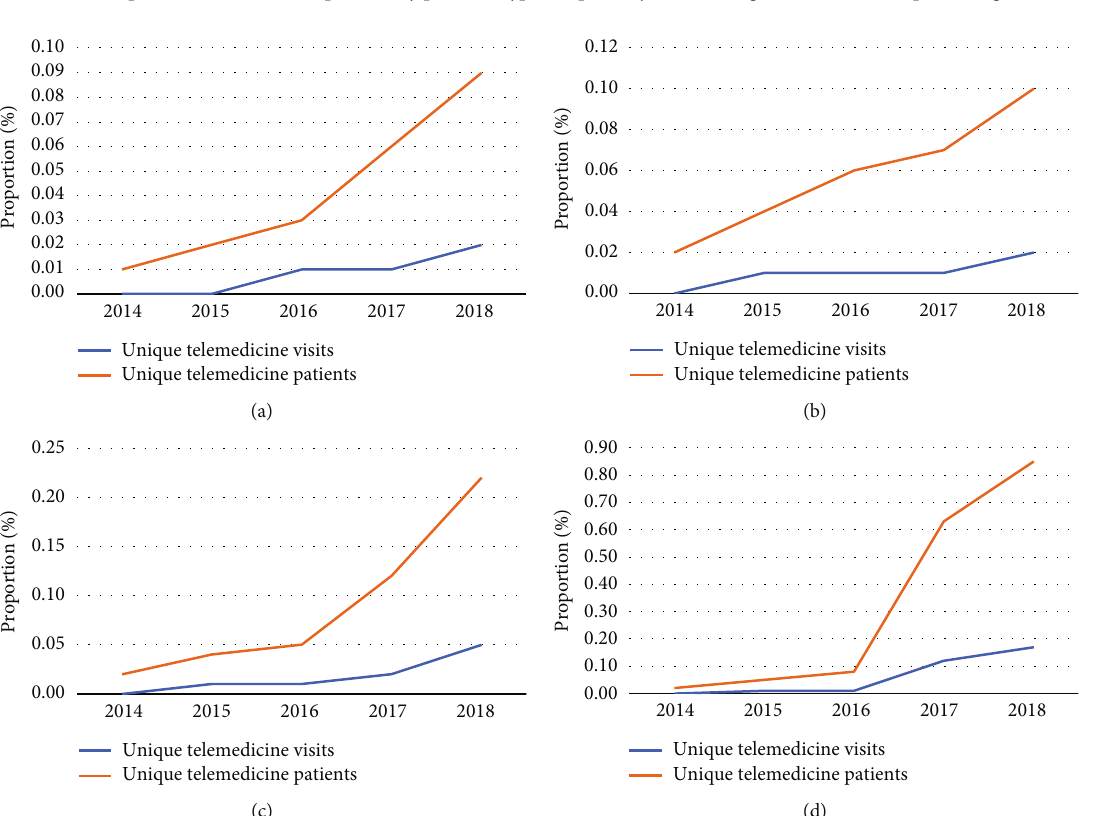
Figure 3: Trends in unique telemedicine visits/patients by provider type: (a) primary care, (b) urgent care, (c) orthopedic surgeon, and (d) other.